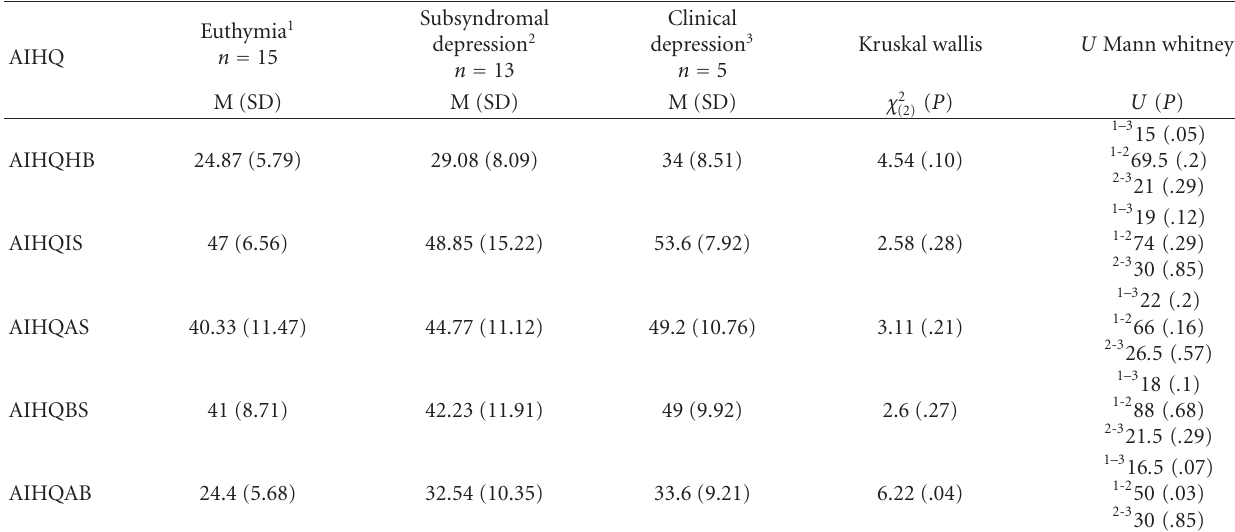
Table 5: Scores in the AIHQ subscales of the bipolar patients in state of euthymia, with subsyndromal depressive symptoms and clinical depression (after subtracting patients with SAD, n =